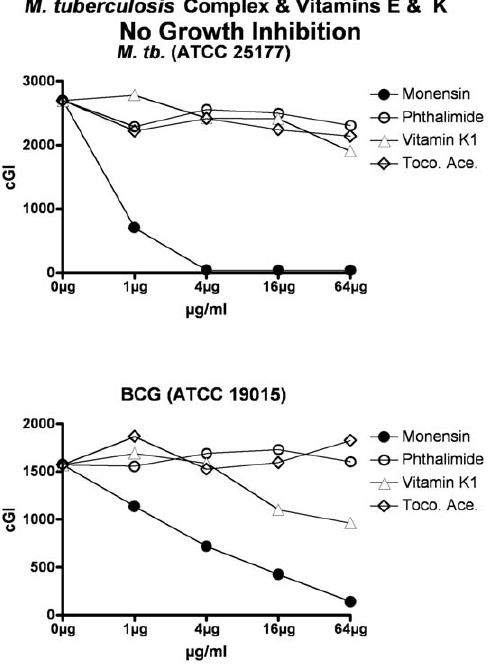
Figure 5. Neither vitamins E nor K inhibit M.avium . The inhibitory control is Monensin, and the non-inhibitory control is Phthalimide. Note that as previously [20,21,30], Monensin does not inhibit M avium 101. cGI=cumulative Growth Index.